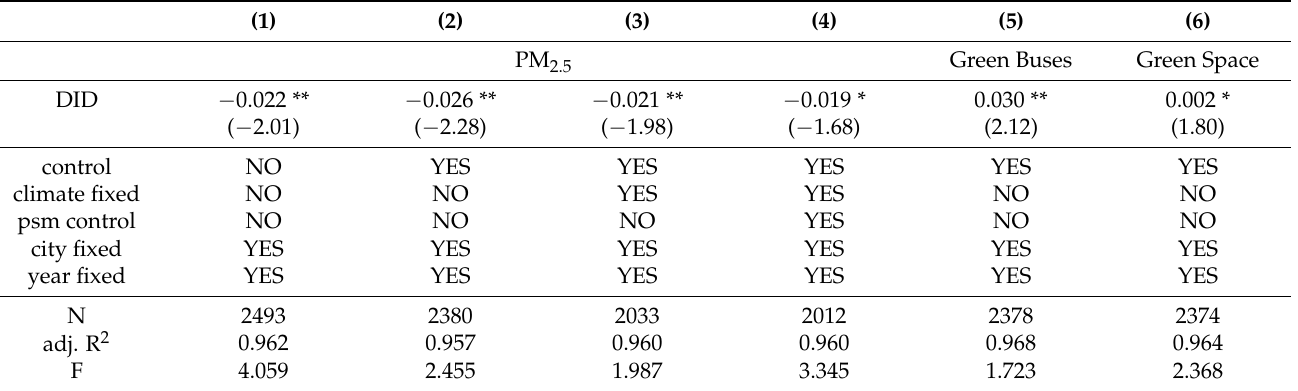
Table 6. Mechanism analysis.